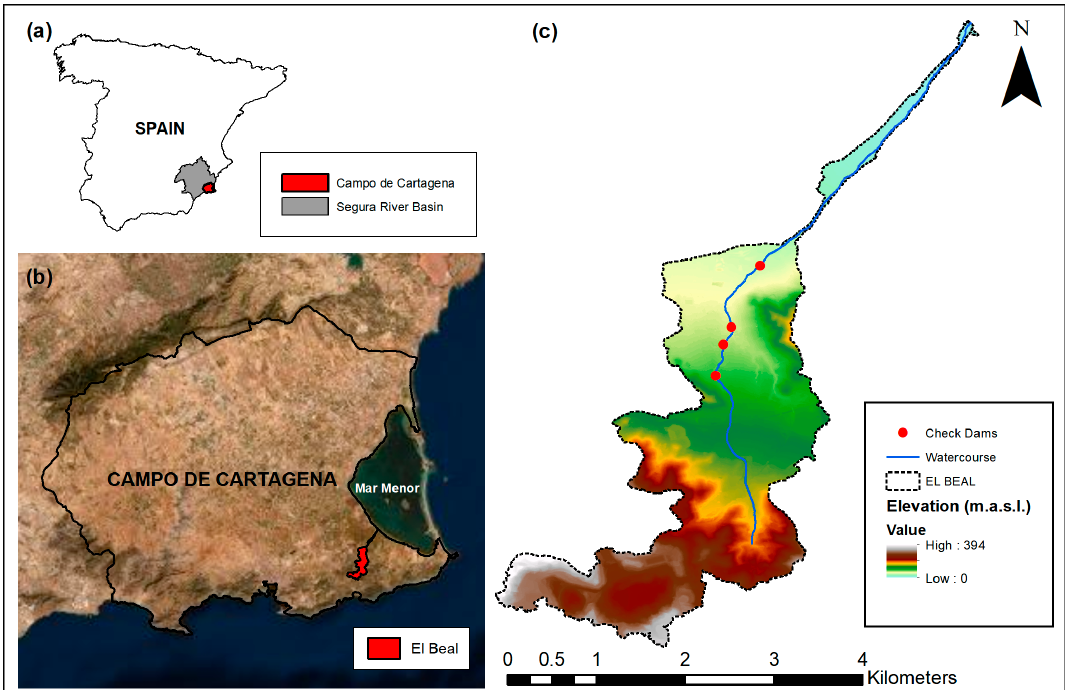
Figure 1. (a) Location map of Campo de Cartagena watershed as part of the Segura River Basin (Spain); (b) Situation map of El Beal within the Campo de Cartagena basin and Mar Menor coastal lagoon location; (c) Digital elevation model (DEM) and check dam location of El Beal watershed.